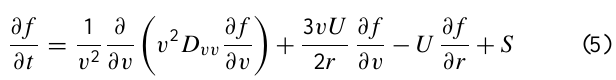
Fig. 2. The normalized wave power spectra ˜ W ( k ) = √ ( e r 0 / ( mcU ) W ( k ) as functions of the normalized wavenumber ˜ k = kU/ Ω E as computed by Chalov et al. (2004). The solid lines are for the case that damping due to resonant interactions between the waves and pick-up protons is taken into account, while the dashed lines are spectral powers for vanishing damping. The ver- tical dotted lines show the solar wind proton dissipation wavenum- bers.